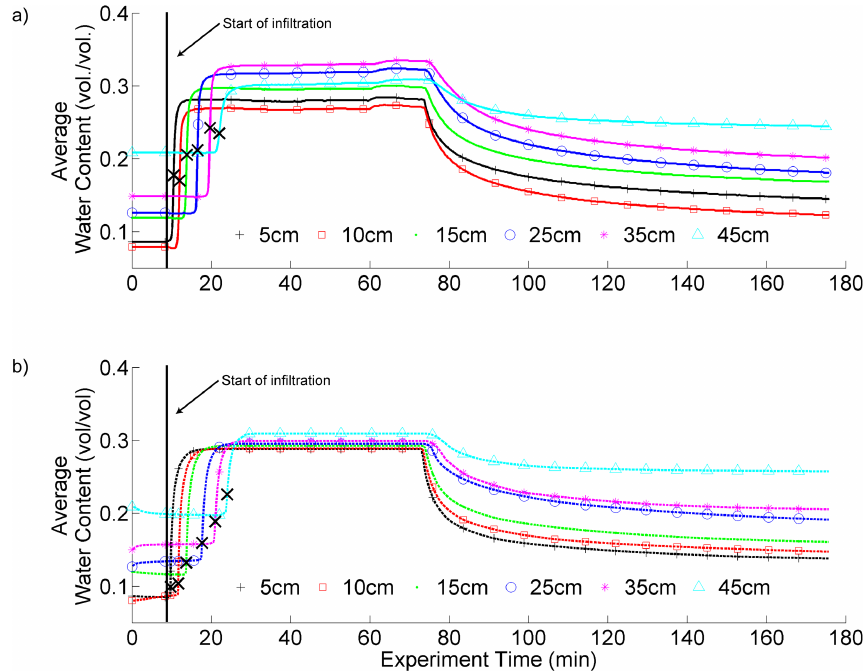
Fig. 2. (a) Data from soil moisture probes located in the central array of the sand tank and (b) HYDRUS-1D model results. “X” marks indicate wetting front picks from taking the maximum of first derivative of the series in